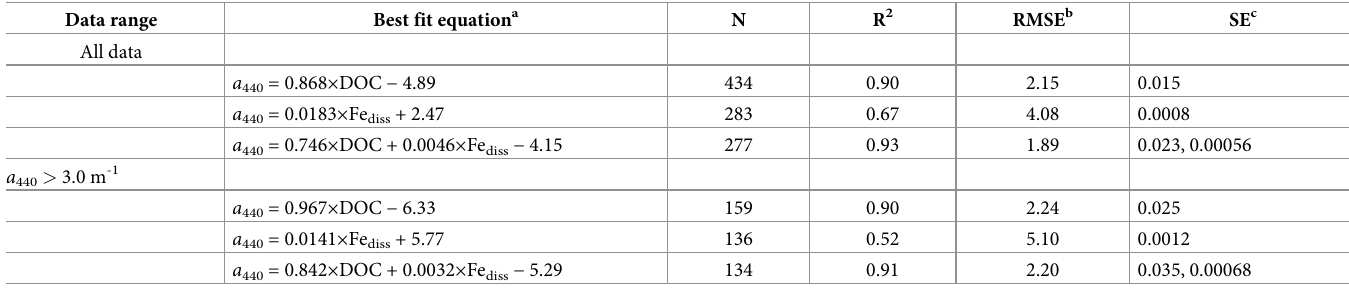
Table 3. Simple and multiple regression relationships for a 440 vs. DOC and Fe diss